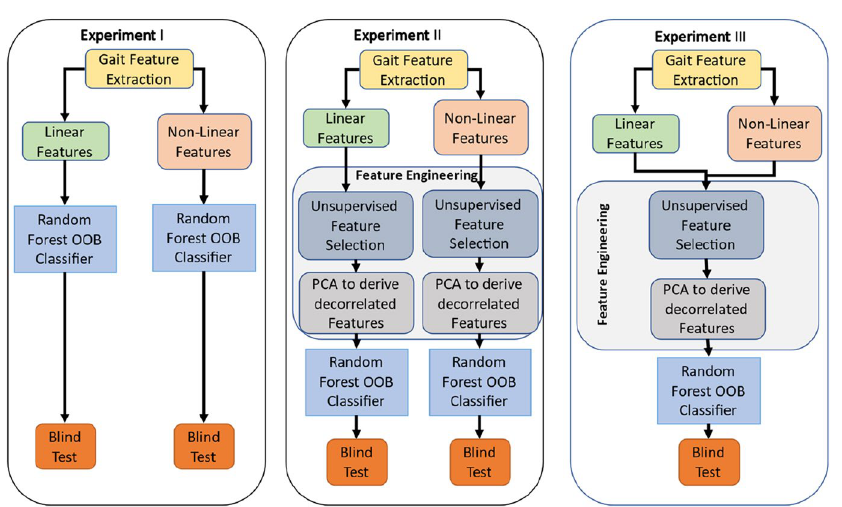
Figure 7. Workflow of three designed experiments (OOB: Out of Bag RF